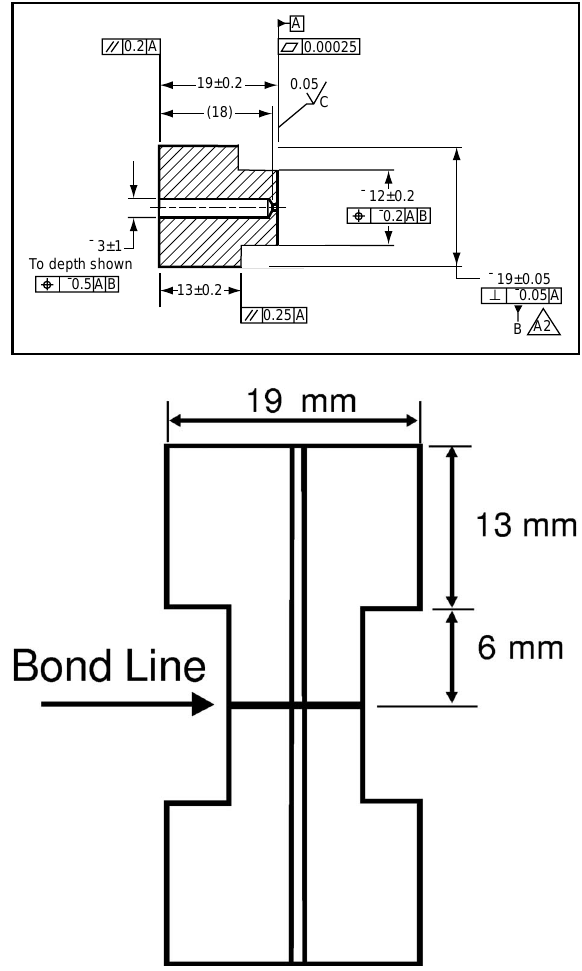
FIG. 3. (Top) Schematic of the reduced section sample before bonding. (Bottom) Reduced section sample after bonding.